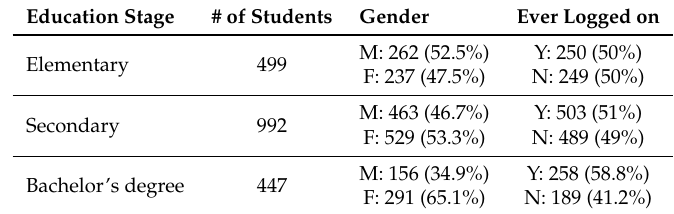
Table 1. Number of students involved in the study grouped by education stage, including gender information and the number of students who have ever logged on.